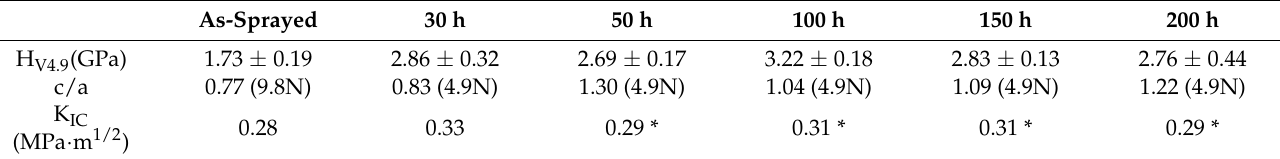
Table 5. Vickers hardness and fracture toughness of as-sprayed and 1100 ◦ C aged CZSO coatings.